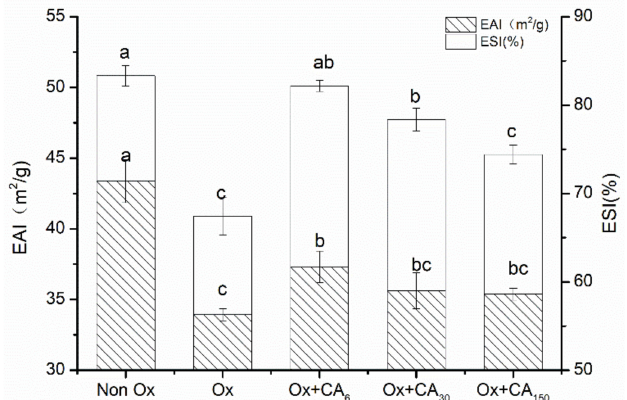
Figure4. Changesinemulsifyingactivity(EAI)andemulsificationstability(ESI)ofoxidizedmyofibrillar protein (MP) treated with chlorogenic acid. Control: nonoxidized; Ox: oxidized; Ox + CA 6 , Ox + CA 30 , and Ox + CA 150 : oxidized in the presence of CA at 6, 30, and 150 µ M / g protein, respectively. Di ff erent lowercase letters denote significant di ff erences (p <